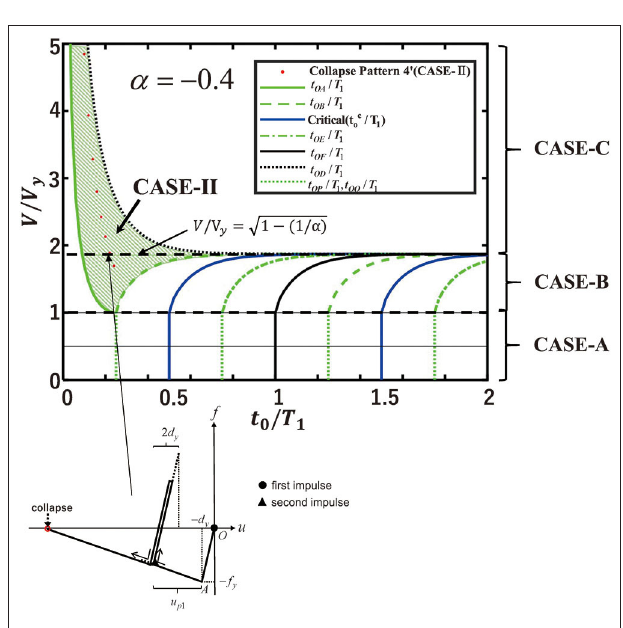
FIGURE 9 | Second impulse timing t 0 / T 1 -input velocity relation for CASE-B and CASE-II, CASE-C, CASE-II in collapse pattern 4 ′ .